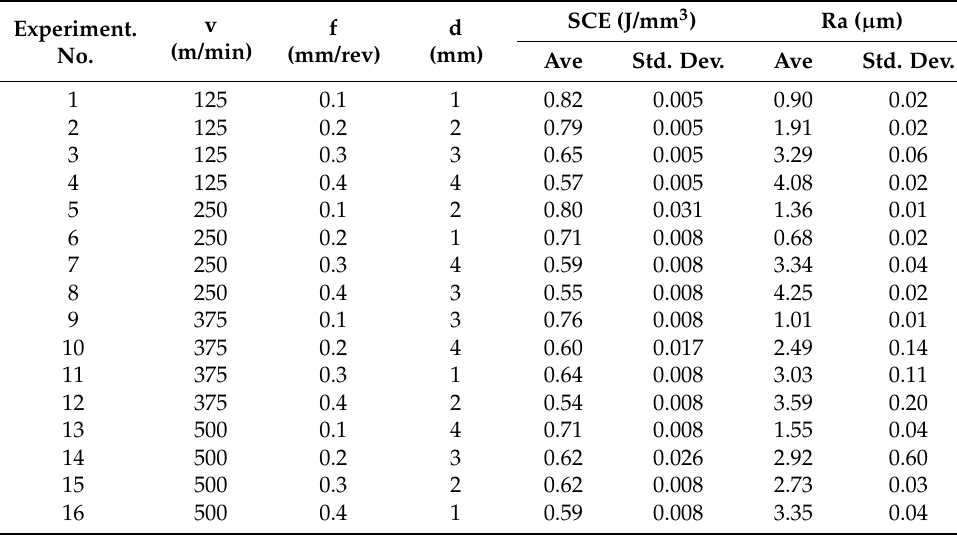
Table 4. Results of L 16 experimental plan for conventional machining range.